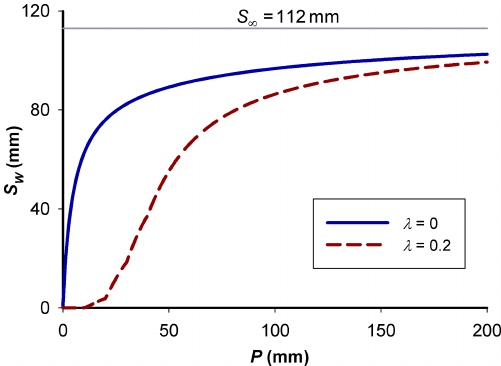
Figure 10. Variation of S W with P in a heterogeneous watershed with the storage distribution shown in Table